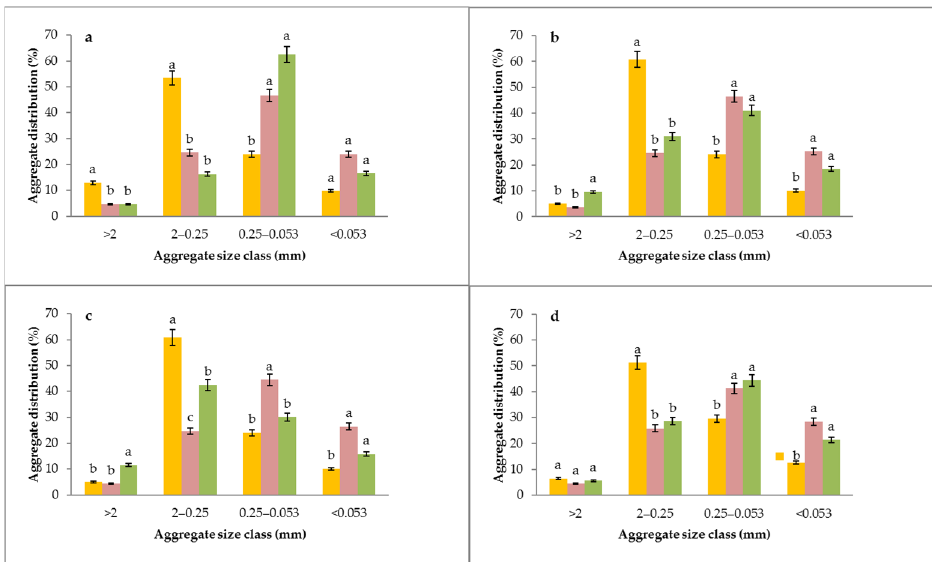
Figure 2. Soil water-stable aggregate size distribution (%) for initial situation (CT0; yellow bars) conventional-tillage (CT1; red bars) and no-till (NT+H; green bars) treatments at different horizons for ( a ) Ap horizon, ( b ) Bw horizon, ( c ) BC horizon and ( d ) C horizon. Values are given as mean ± standard error (n = 5). The different lowercase letters above the error bars for the same aggregate fraction indicate significant differences based on post-hoc tests and Tukey’s honestly significant difference (HSD) at p < 0.05 between management.